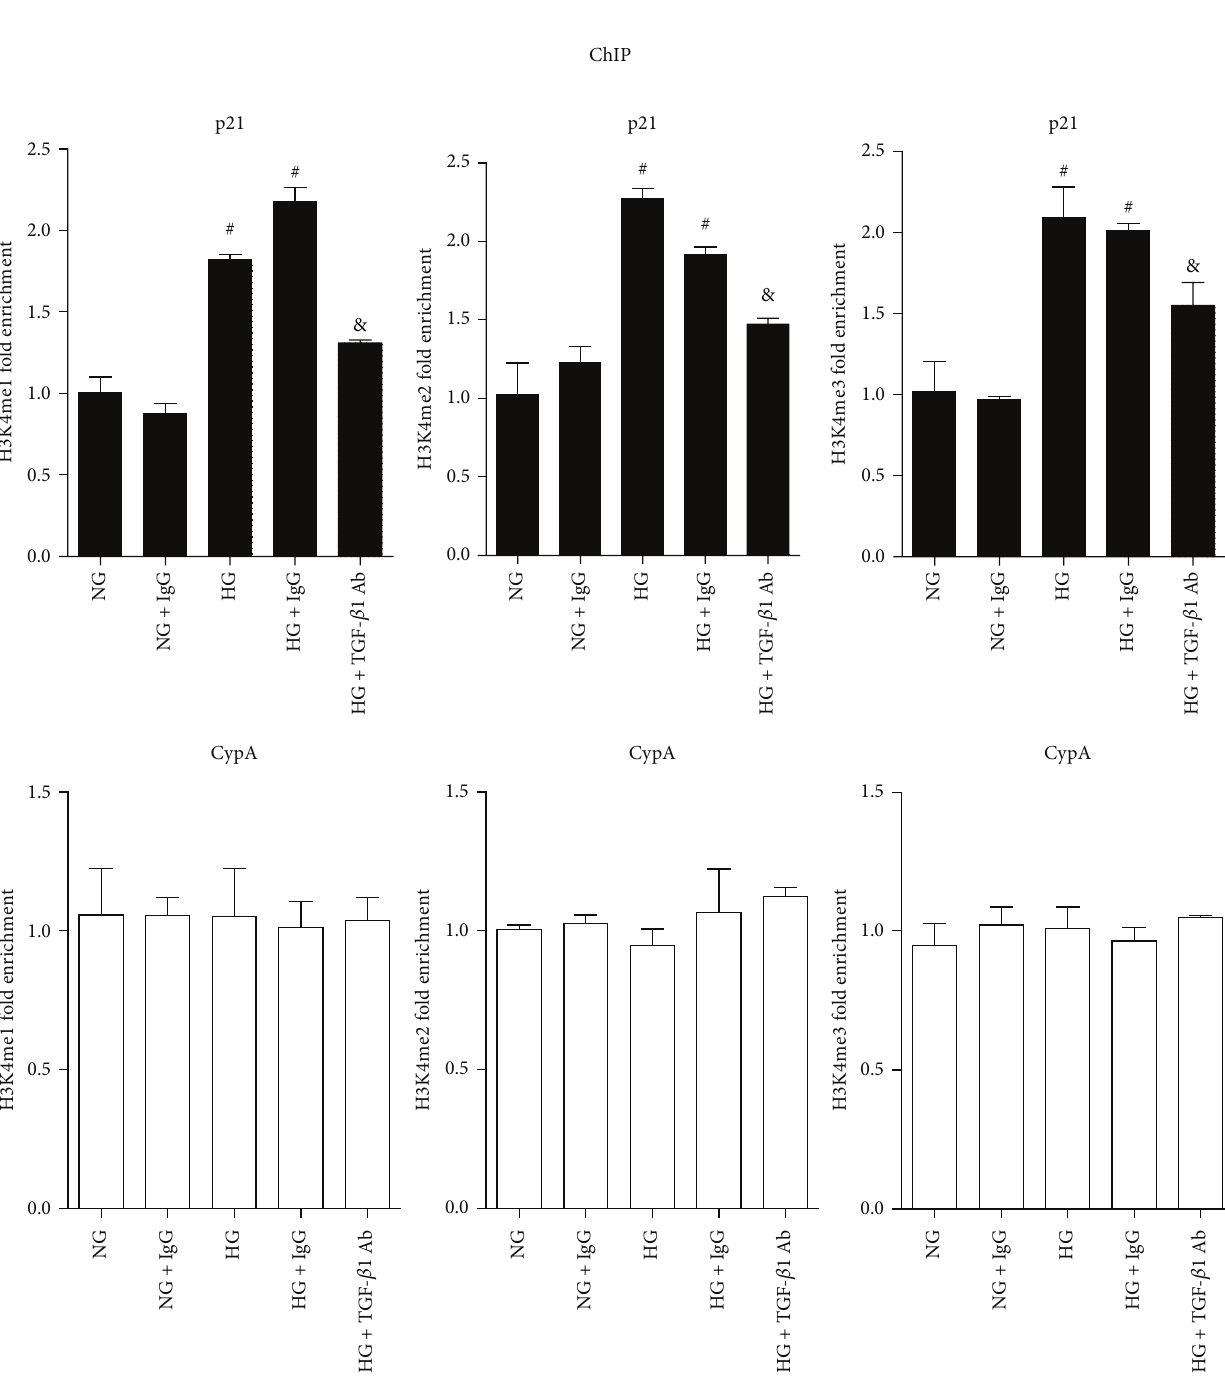
were inversely associated with upregulated expression of these genes including Col1 𝛼 1, CTGF, and PAI-1